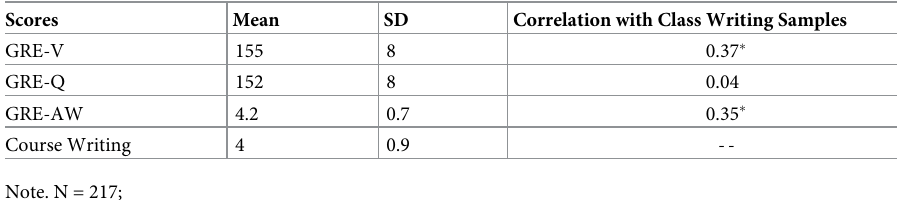
Table 6. Correlation of GRE scores with scores from course-required writing samples.